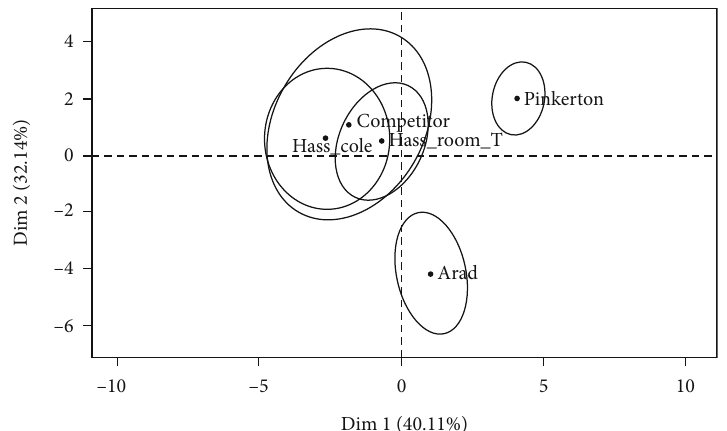
Figure 5: Dimension 1 (Dim 1) and dimension 2 (Dim 2) of the multiple factor analysis individual plot of avocado samples and con fi dence